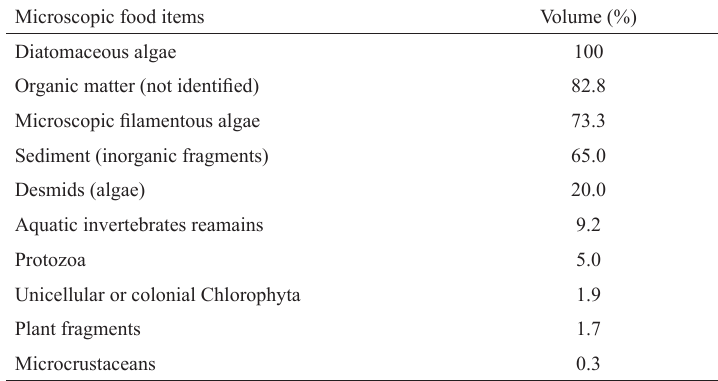
Table 2. Mean relative volume of microscopic food items found in the stream-dwelling characid fish Deuterodon stigmaturus . Microscopic items were analyzed from the macroscopic food items previously classified as